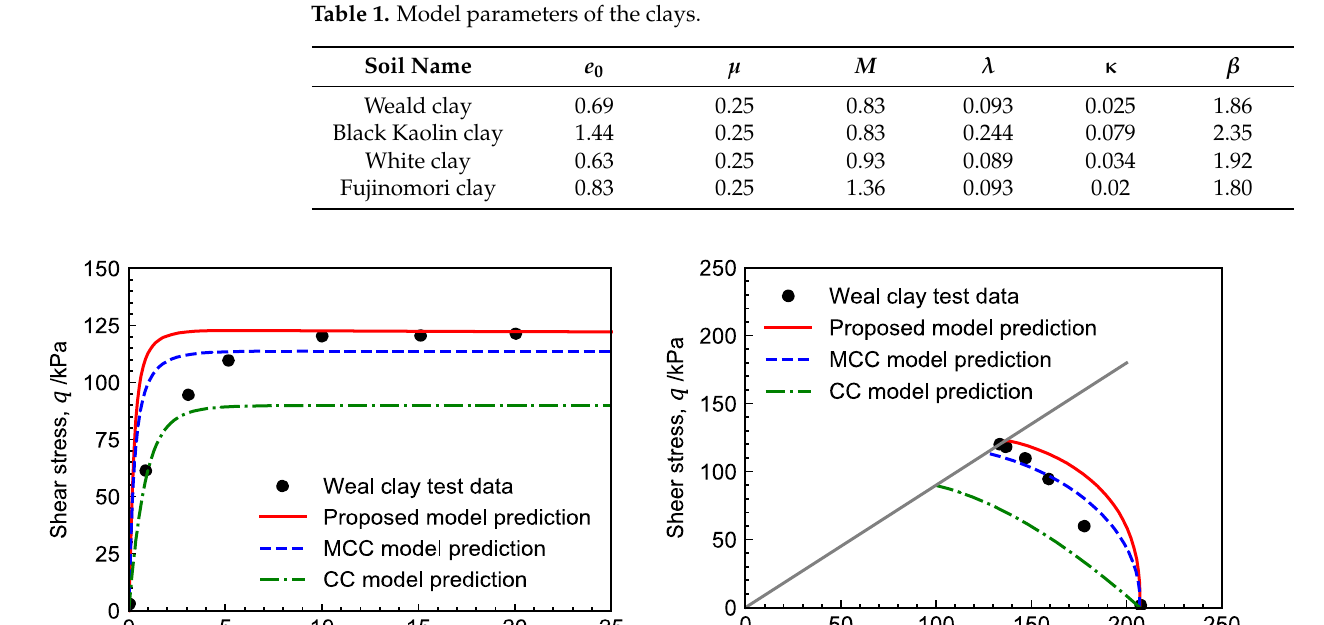
Table 1. Model parameters of the clays.